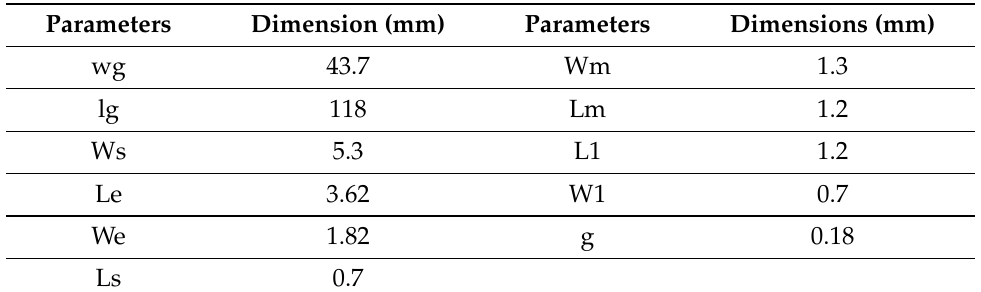
Table 1. Parameters of proposed unit cell and MIMO antenna (all dimensions are in mm).